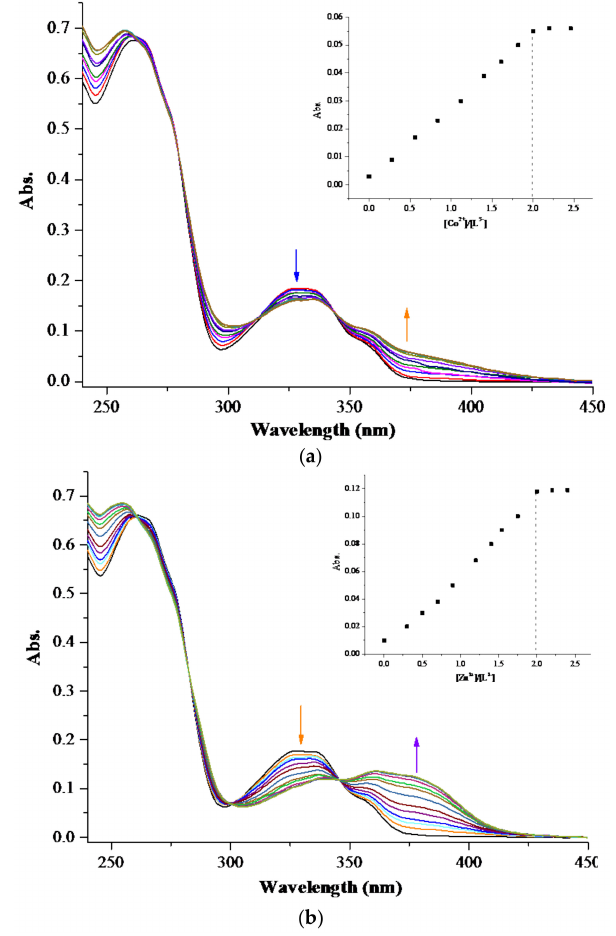
Figure 6. UV-Vis spectral changes of the coordination compounds 1 ( a ) and 2 ( b ) upon addition of different amounts of Co II and Zn II ions (MeOH (1 × 10 − 5